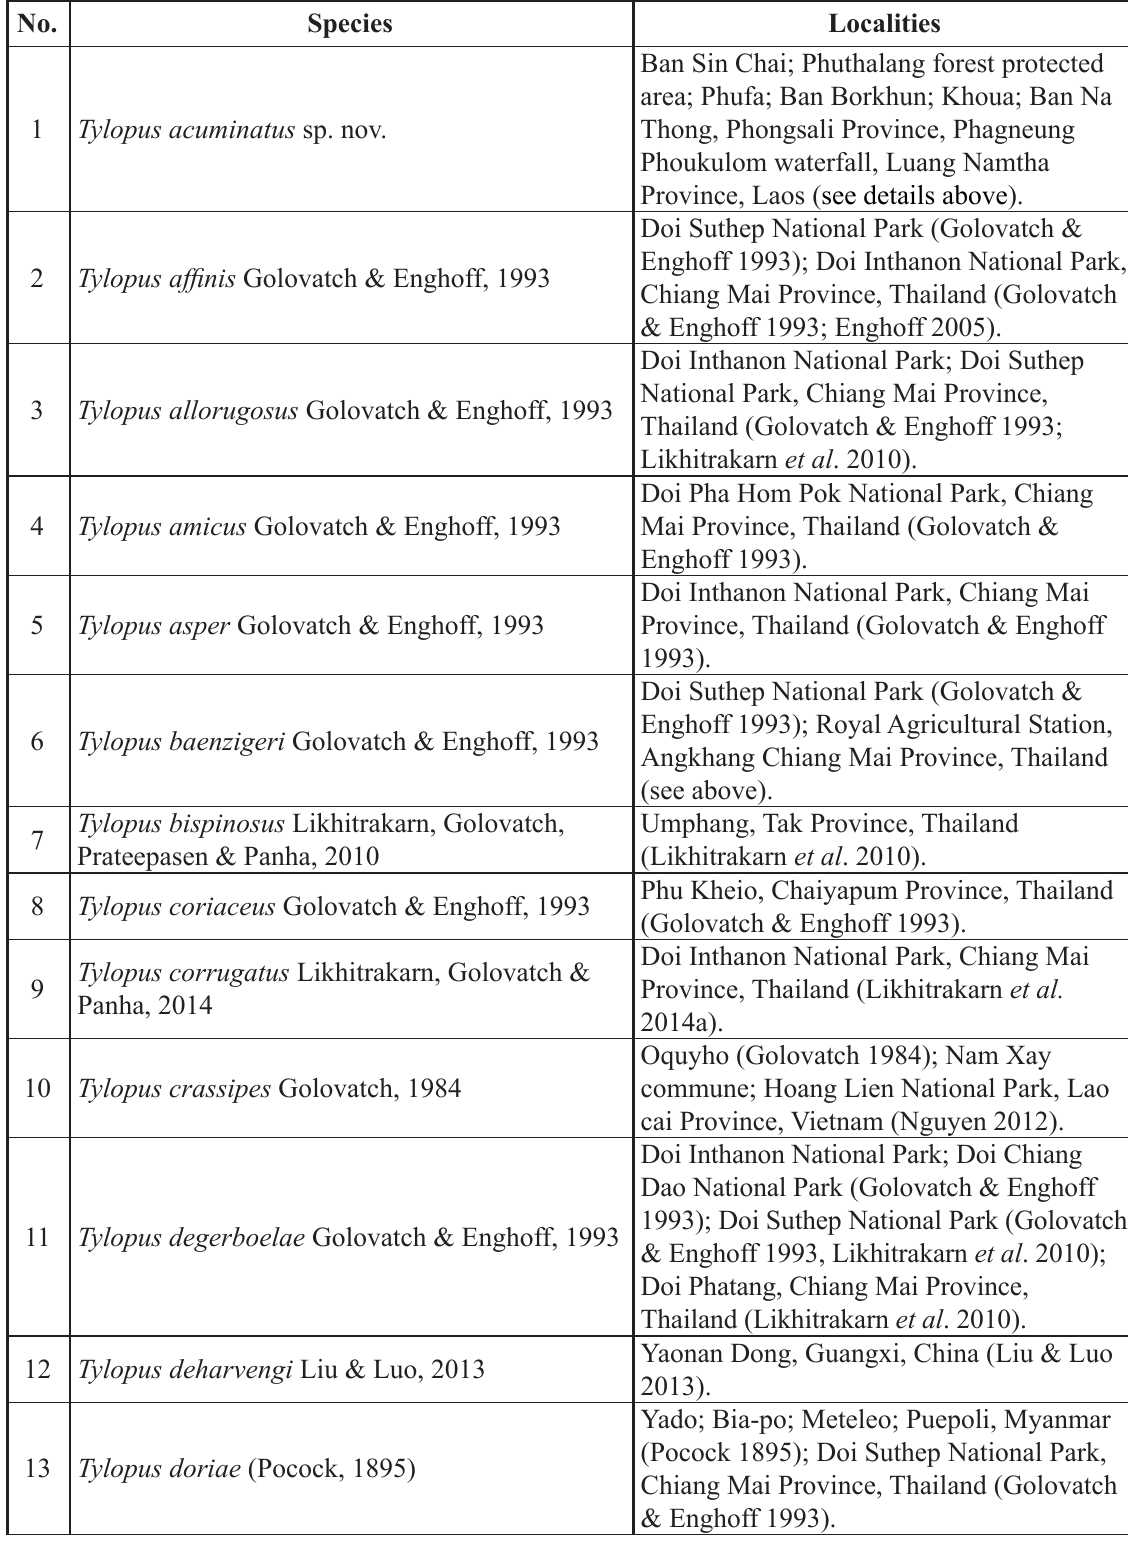
Table 1. records of Tylopus